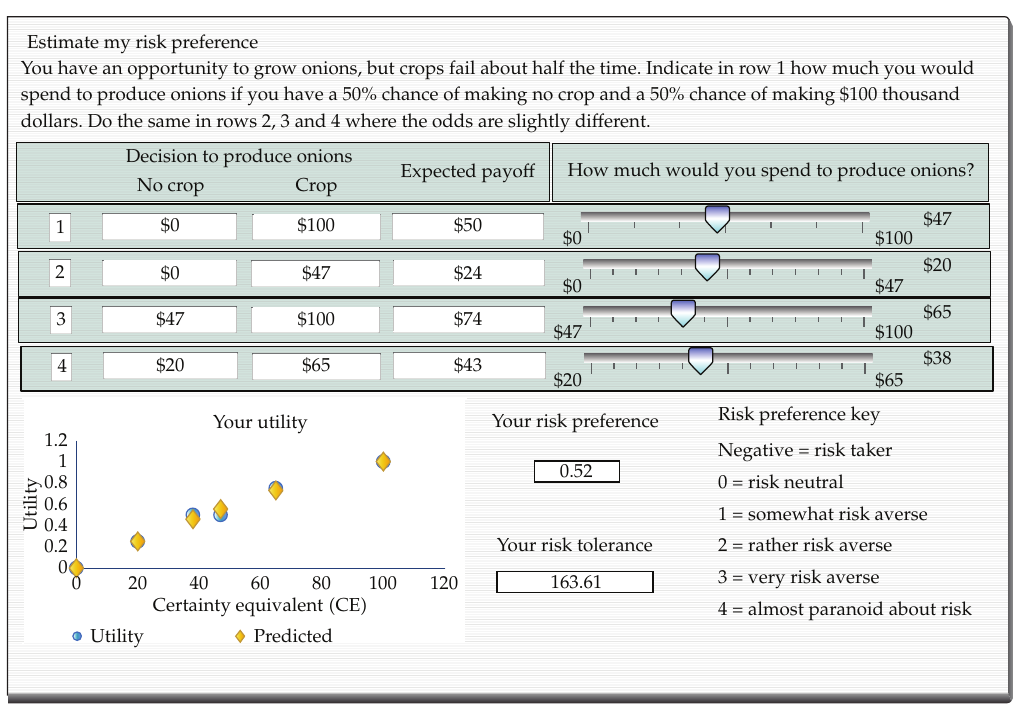
Figure 2: Elicitation of risk preference/tolerance in Risk Preference Calculator. See source in (cid:4) 6 (cid:5) .